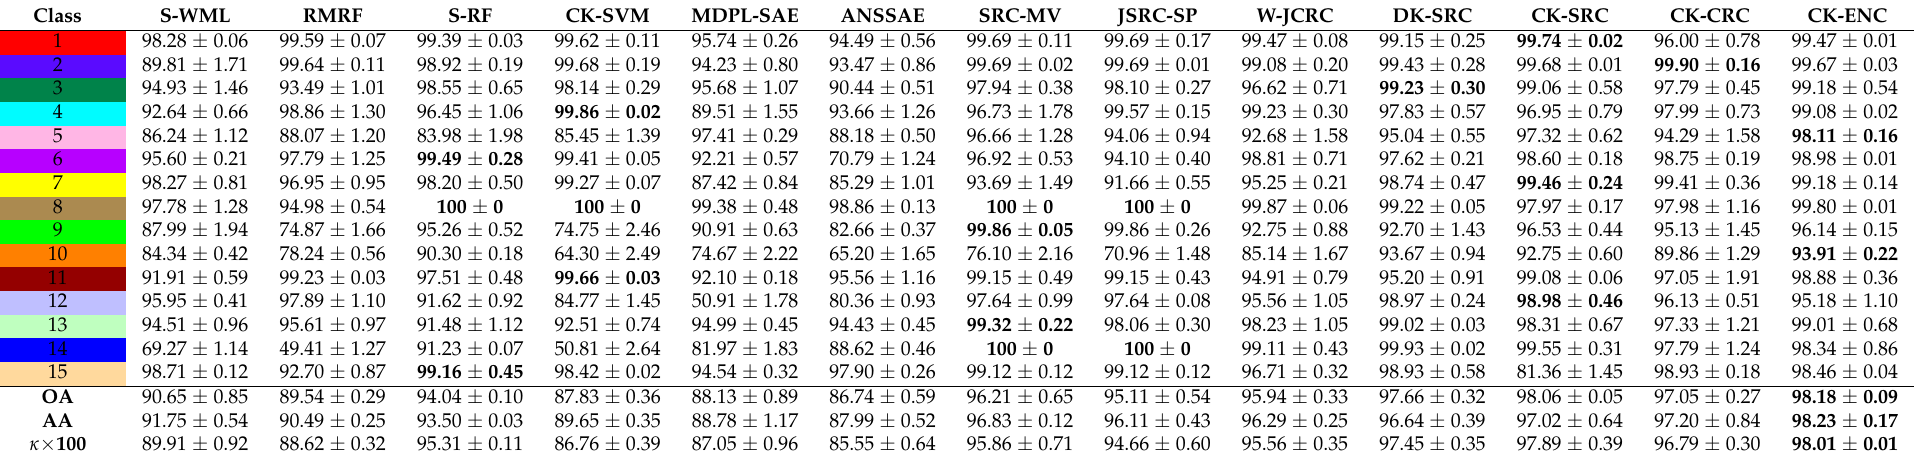
Table 2. Comparision of classification performances on the Flevoland